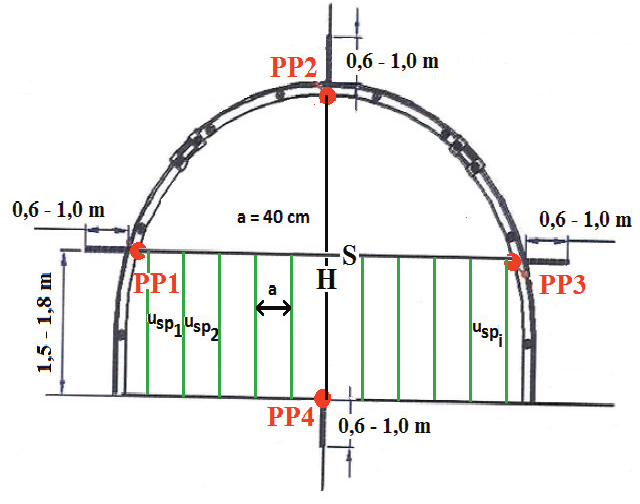
Fig. 1. Scheme of measurement base and the measurement methodology in D-2